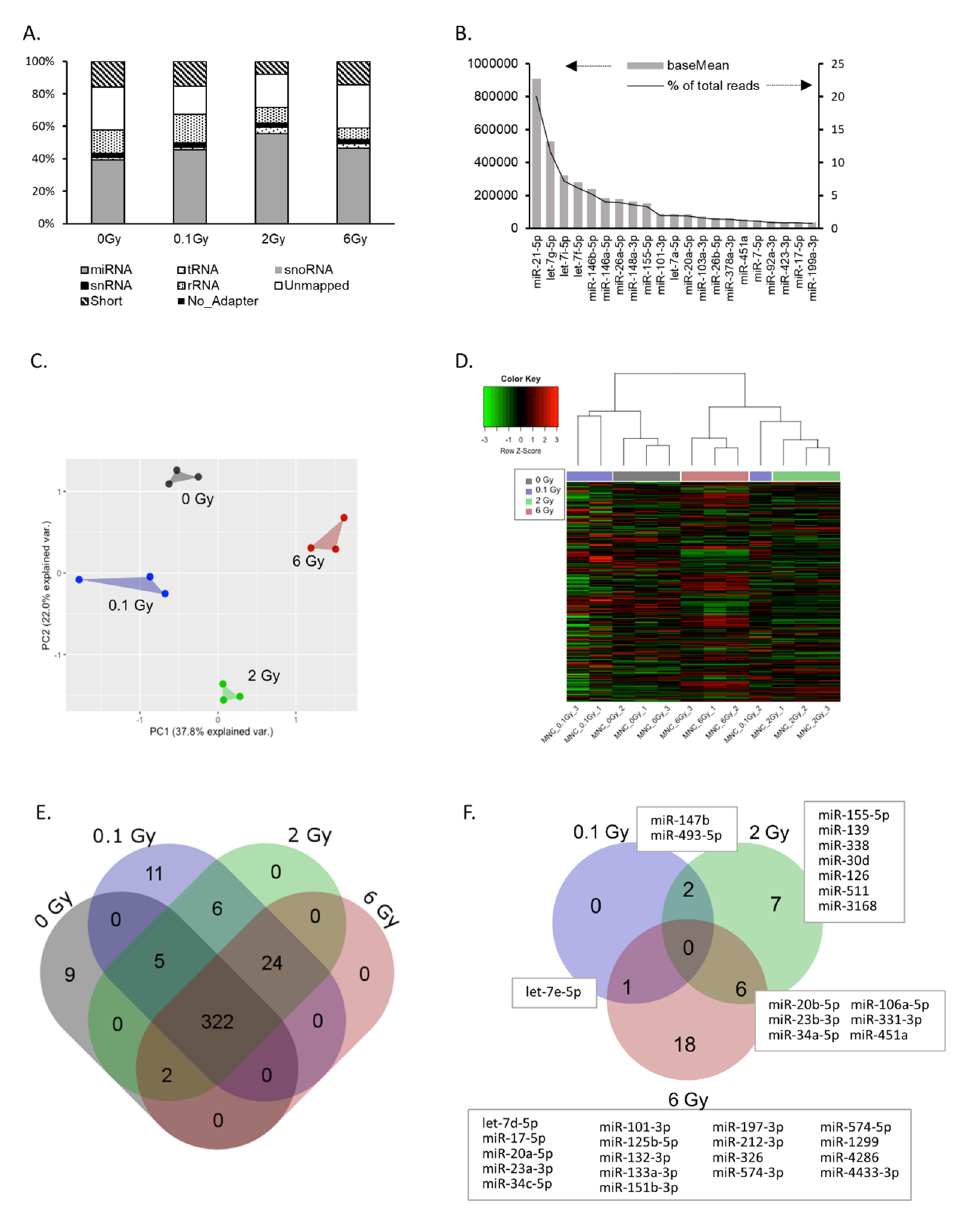
Figure 2. microRNA cargo of extracellular vesicles (EVs) derived from peripheral blood mononuclear cells (PBMCs). ( A ) Percentage of total reads mapped to non-coding small RNAs identified by small RNA sequencing. Short—sequence is shorter than 15 nt; unmapped—sequence did not align to human rRNA, snRNA, snoRNA, tRNA or miRNA. ( B ) Top 20 highly-expressed miRNAs in PBMC EVs (reads per million—RPM, data are expressed as mean mapping percentages). ( C ) Principle component analysis based on the reads of all identified miRNAs in EVs. ( D ) Hierarchical clustering of EV miRNA expression. ( E ) Venn diagram showing total and shared numbers of miRNAs identified at the indicated doses. ( F ) Venn diagram showing the number of total and shared miRNAs deregulated by irradiation. miRNAs are identified with a base mean ≥ 50. A log 2 fold change ≥ | 1 | together with an adjusted p -value ≤ 0.05 are set as criteria for deregulated miRNAs.